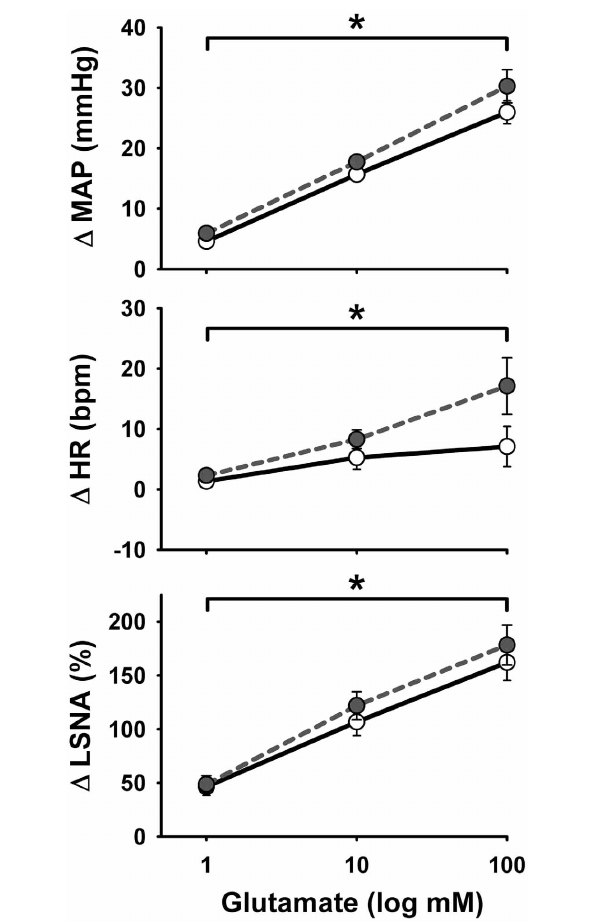
FIGURE 1 | Peak mean arterial pressure (MAP), heart rate (HR), and lumbar sympathetic nerve activity (LSNA) responses to activation of the rostral ventrolateral medulla with increasing concentrations of glutamate (30nl) in sedentary (filled circles, n = 16) and physically active rats (open circles, n = 17). There was a significant effect of glutamate concentration to increase MAP, HR, and LSNA ( ∗ p < 0 . 05) but responses did not differ between groups.